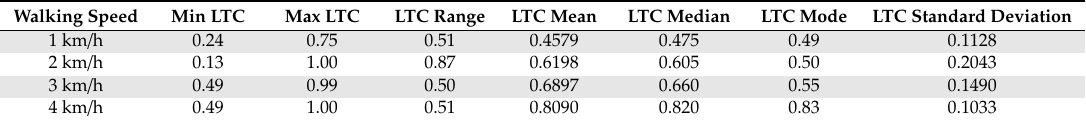
Table 9. Data statistics for linear temporal correlation (LTC) between ground truth data and VitalCore data for respiratory peak detection.